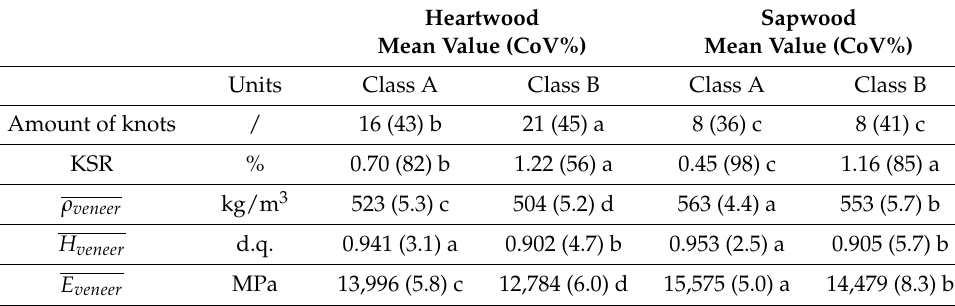
Table 5. Data from stiffness profile classes.